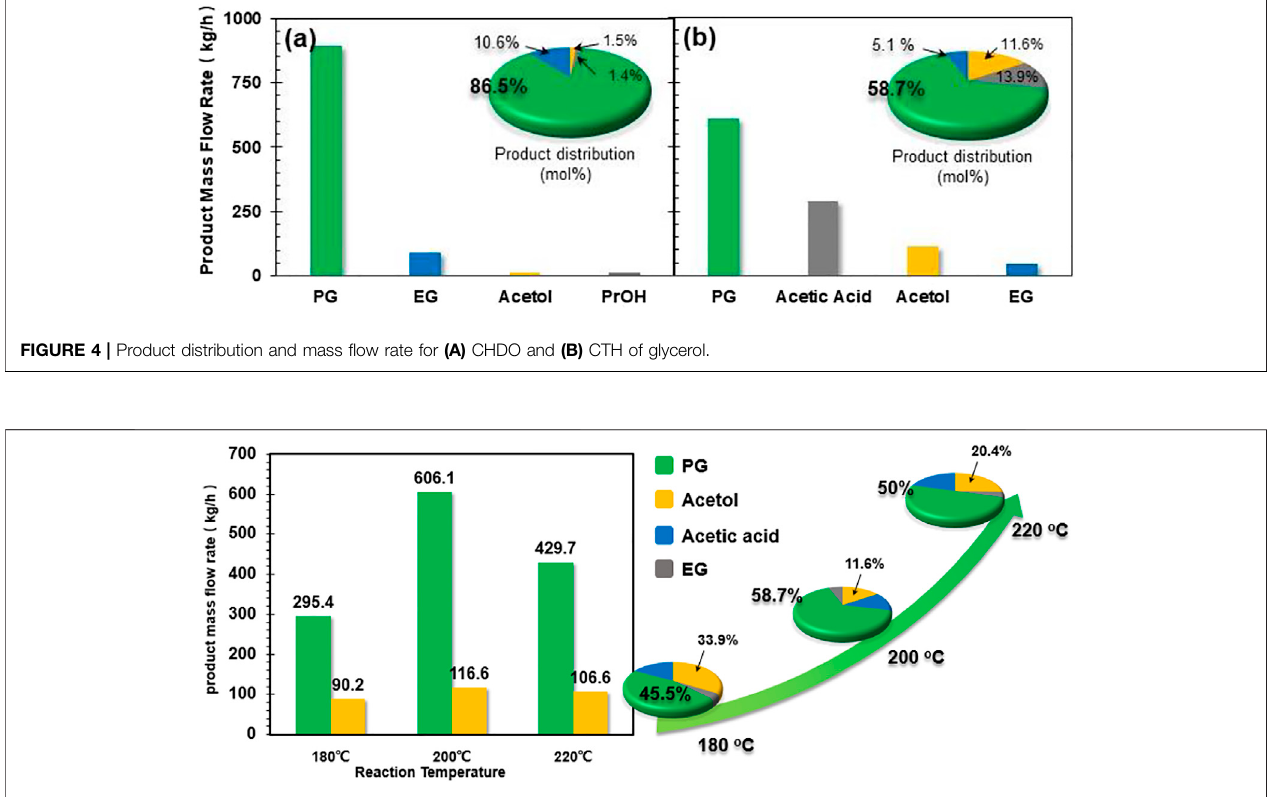
FIGURE 5 | In fl uence of reaction temperature on product fl ow rate and